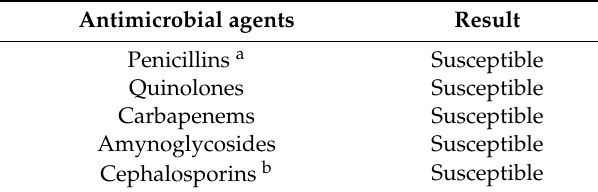
Table 2. Antibiotic resistance pattern determined with the MicroScan